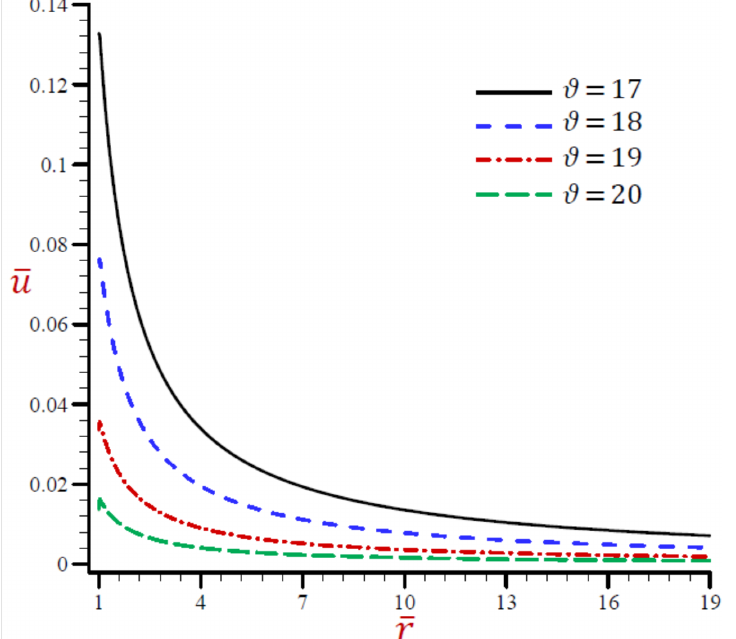
Figure 15. Effect of ϑ on radial displacement u across the radial direction of the cylindrical cavity utilizing the RDPL